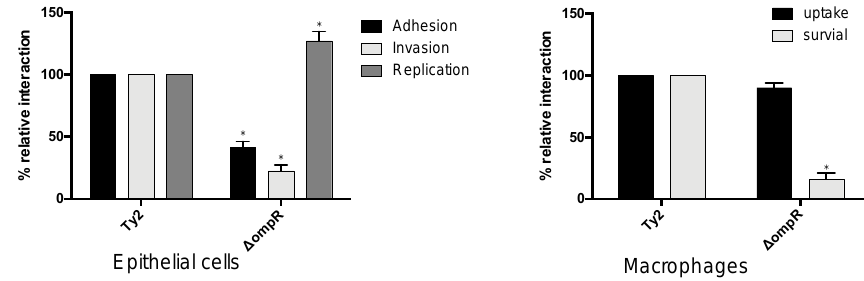
Figure 5. Role of ompR mutant in S. Typhi strain Ty2. Epithelial INT-407 cells and THP-1 macrophages were infected with S . Typhi Ty2 strain and its isogenic ompR mutant. All assays were conducted in triplicate and repeated independently at least three times. The results are expressed as the mean ± SEM of the replicate experiments. Significant di ff erences (* p < 0.05) compared to the wild-type were determined by the Student’s unpaired t